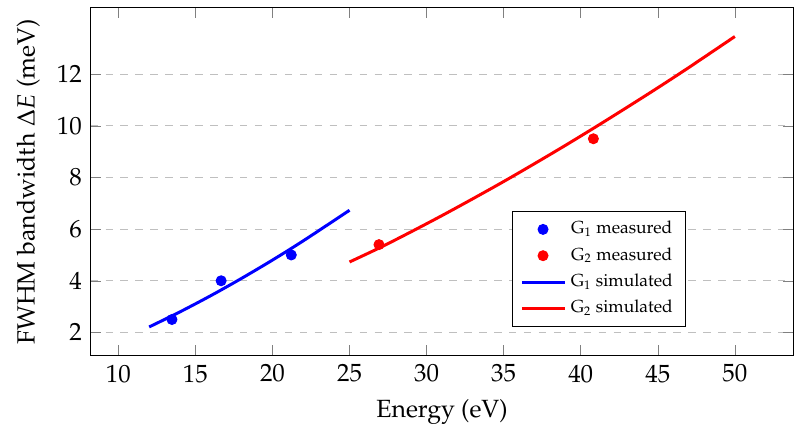
Figure 8. Full-width-at-half-maximum (FWHM) bandwidth measured on the exit slit plane (dot-points) and theoretical best-fit assuming a 37 µ m entrance slit (solid